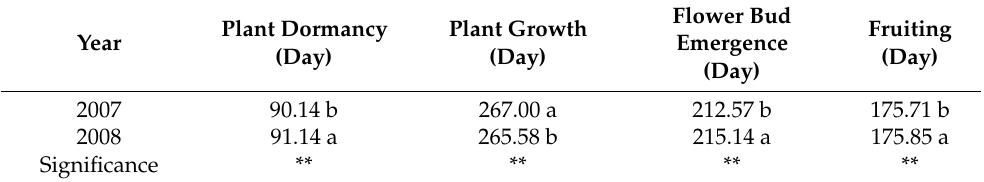
Table 6. Average days per year corresponding to phenological stages.